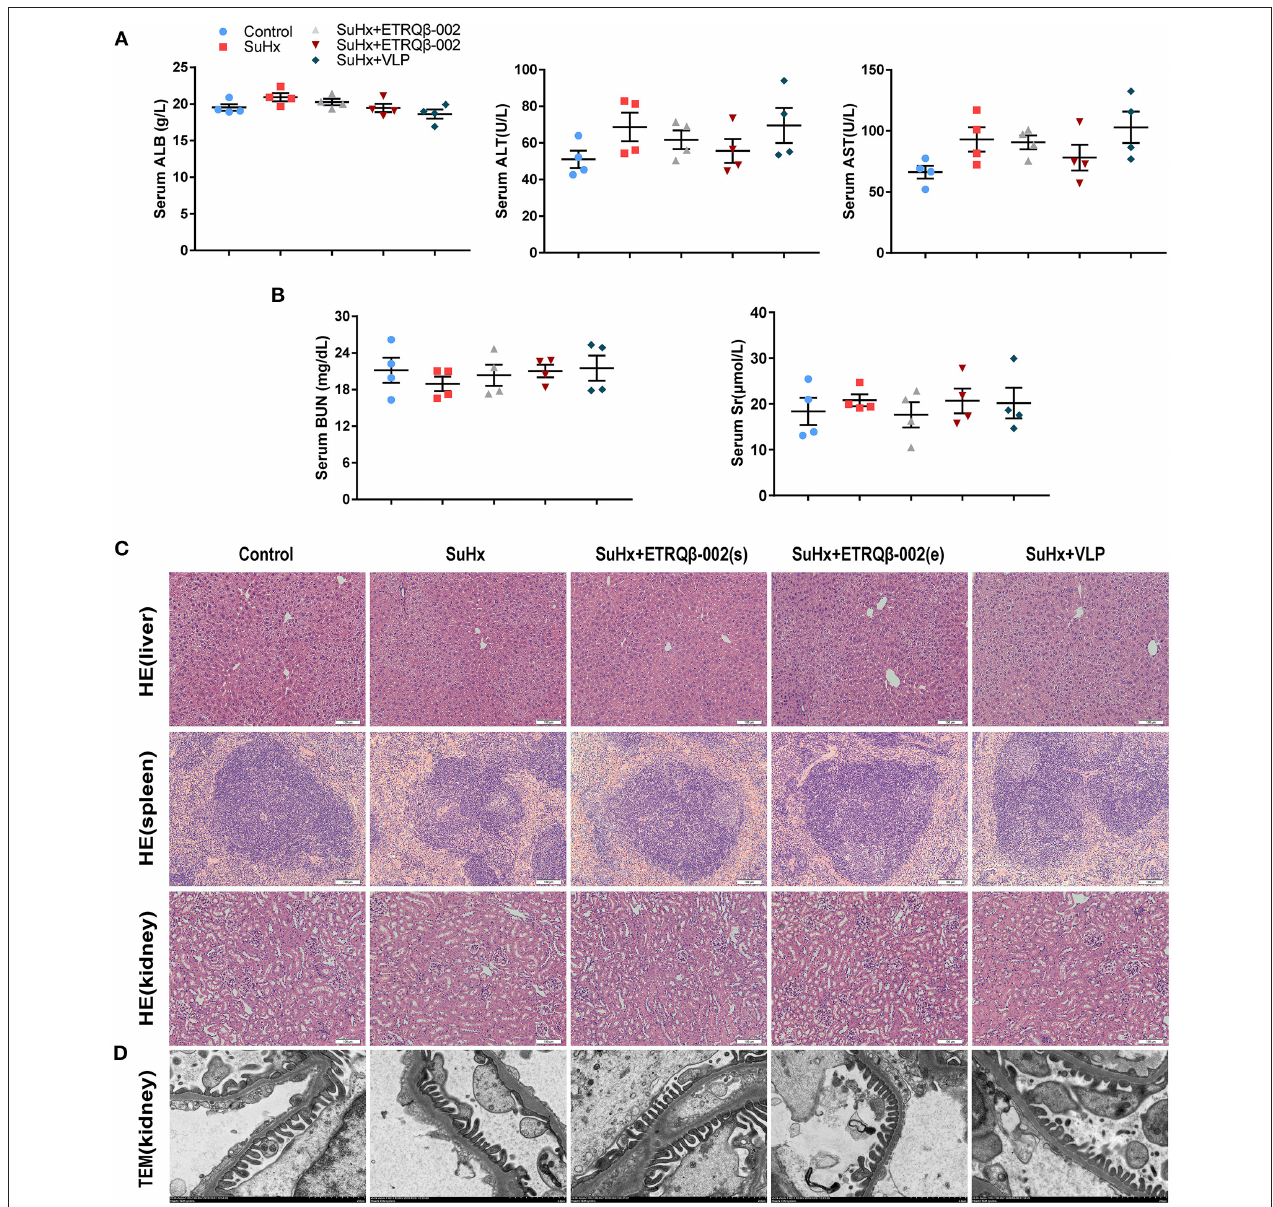
FIGURE 6 | No immune-mediated injury was observed in mice injected with ETRQ β -002 vaccine during a long-term observation. (A) The hepatic function (ALT, AST, and ALB, n = 4). (B) The renal function [serum creatinine (Scr) and blood urea nitrogen (BUN), n = 4]. (C) The representative photographs of hematoxylin-eosin (HE) of the critical organs (liver, spleen, kidney) in the five groups (scale bar = 100 µ m). (D) Transmission electron microscope image of kidney from the five groups (scale bar = 2 µ m). All data are expressed as the mean ±